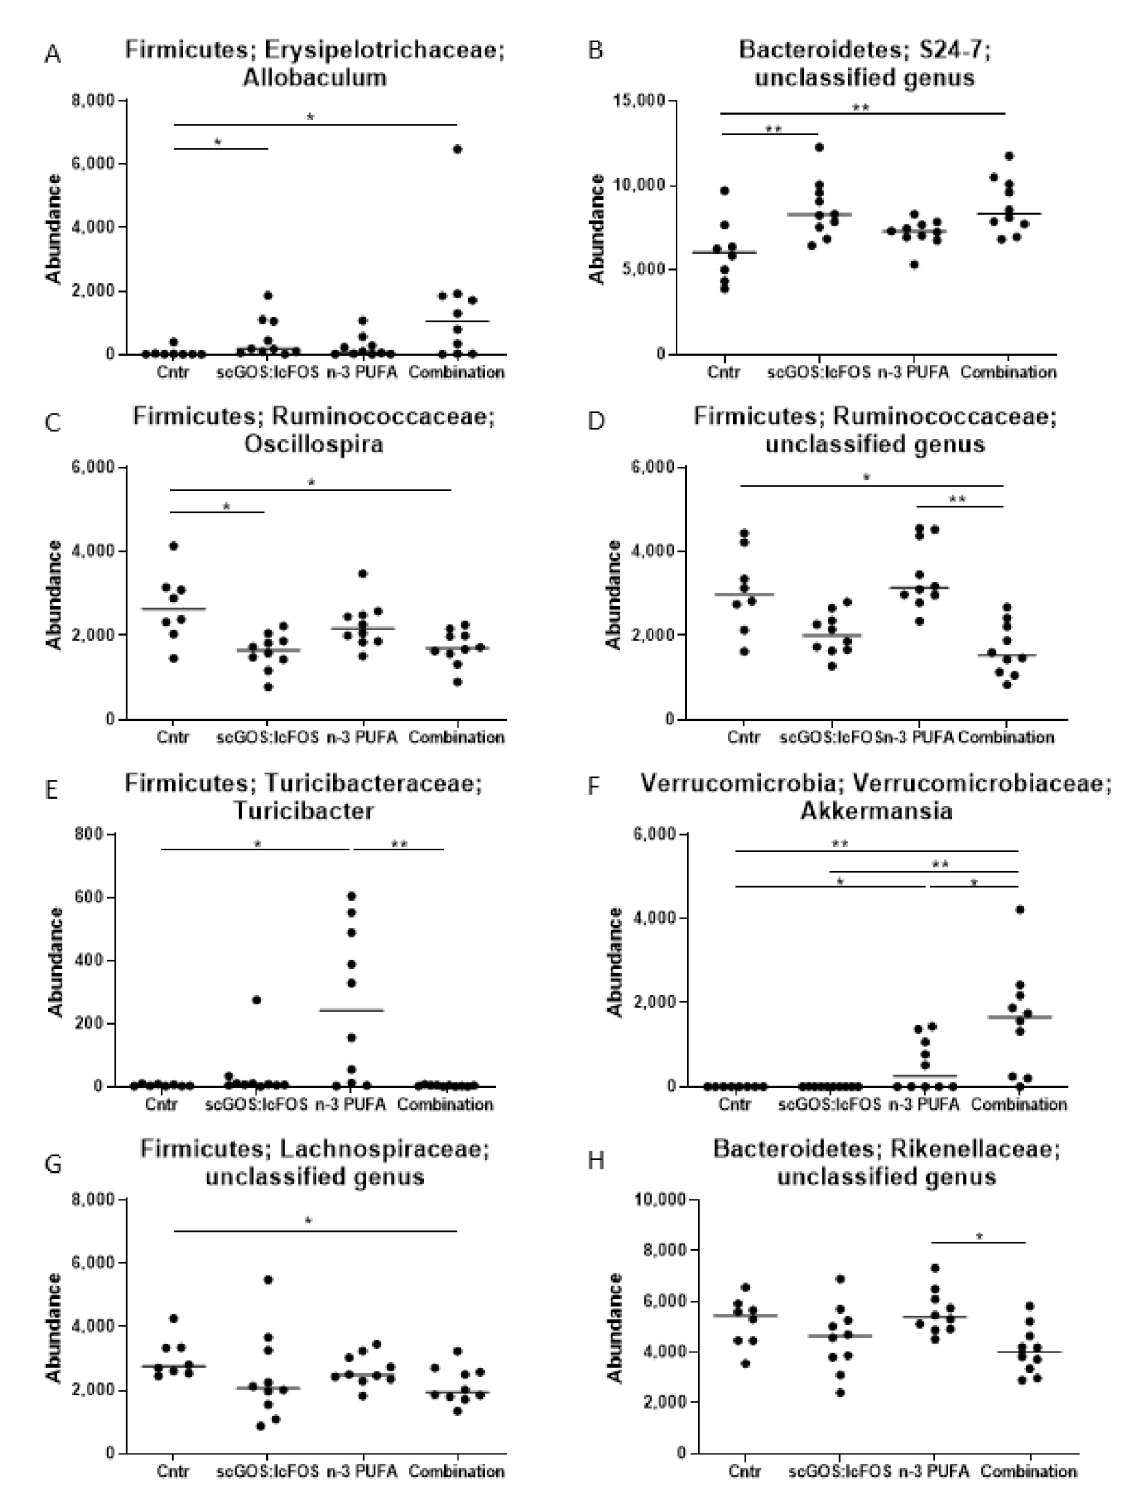
Figure 4. Significant genera taxa-specific relative abundances across mice groups (caecum content). The abundances of eight significant genera across mice groups are identified as: ( A ) Allobacu- lum, ( B ) S24-7 Unclassified, ( C ) Oscillospira, ( D ) Ruminococcaceae Unclassified, ( E ) Turicibacter, ( F ) Akkermanisa, ( G ) Lachnospiraceae Unclassified, and ( H ) Rikenellaceae Unclassified. ( A – H ): Data shown as individual data points and median. Assessed for significance using Kruskal–Wallis test controlling for false-discovery rate (FDR): * FDR-P < 0.05, ** FDR-P < 0.01. n = 8–10 mice per